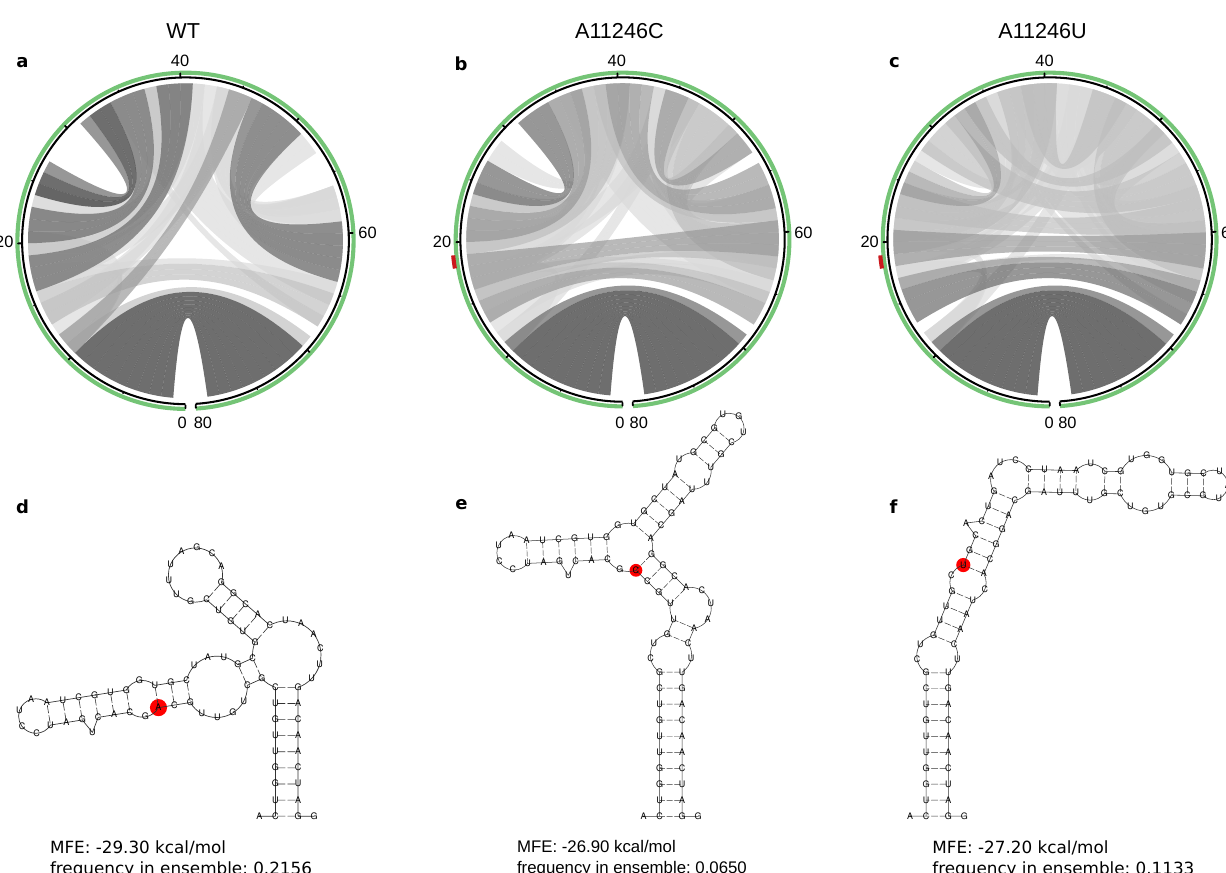
Figure 4. Aberration of the thermodynamic ensemble of a locally stable RNA element induced by mutations at position 11,446, represented here as A19C and A19U. Structural diversity of the thermodynamic ensembles is shown in circle plots ( a – c ), where hue levels of gray represent pairing probabilities. The closing stem of 9 stacked base pairs is formed in all three variants, while the central parts of the RNA from positions 10–70 show varied base pairing patterns. The SNV at position 19 is highlighted in red on top of the green circles in ( b , c ) as well as in the minimum free energy structures ( d – f